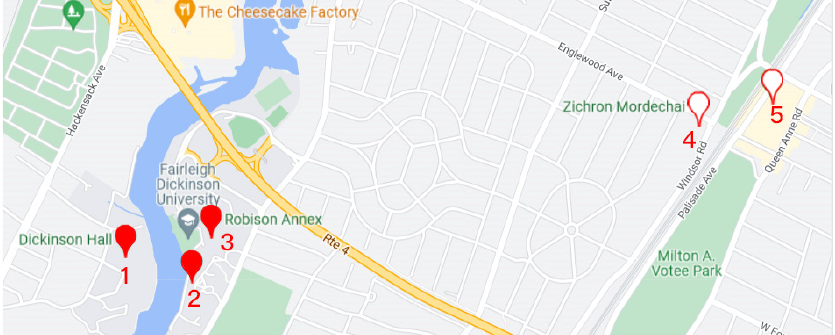
Figure 1. Examples of trajectories showing the relation between non-consecutive visits and non- adjacent locations, the markers 1 through 5 are the most frequently visited locations by a user.